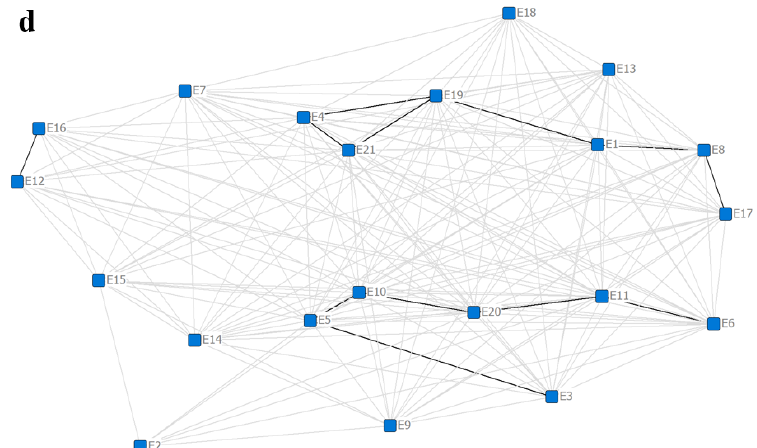
Figure 9. Jaccard similarities for both low ( a , c ) and high ( b , d ) influence networks for stakeholders ( a , b ) and elements of the shared vision ( c , d ) for the RRB. Light grey ties show Jaccard similarities below 0.5. Black ties show Jaccard similarities greater or equal than